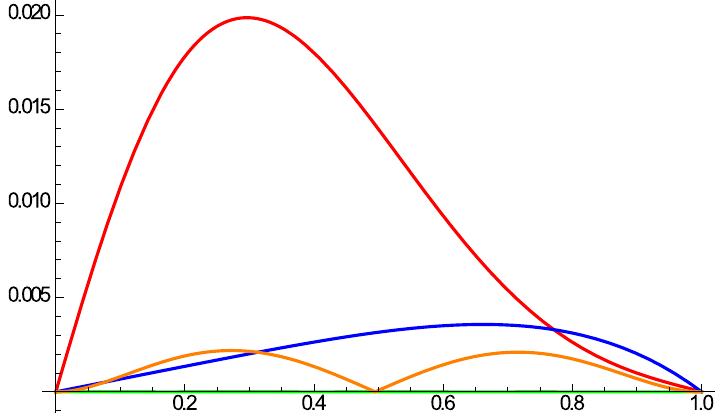
Figure 1. Comparison of absolute errors corresponding to the approximation from [12] U DTM (red curve), [10] U HPM 3 terms (blue curve), [32] U PLSM (orange curve), and our LSHPM approximation U LSHPM (green curve).